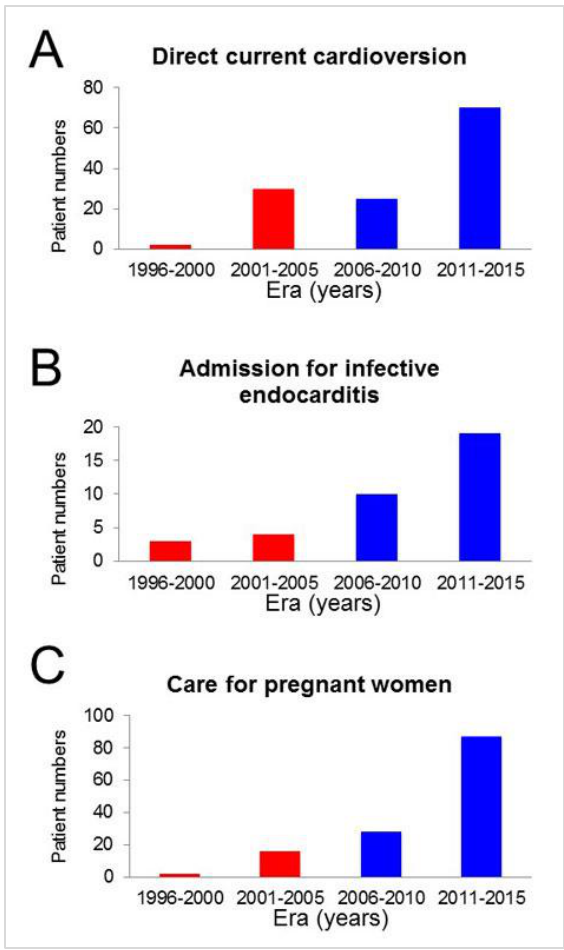
Figure 4: Number of direct current cardioversions (panel A), number of admissions for infective endocarditis (panel B) and number of women followed during pregnancy (panel